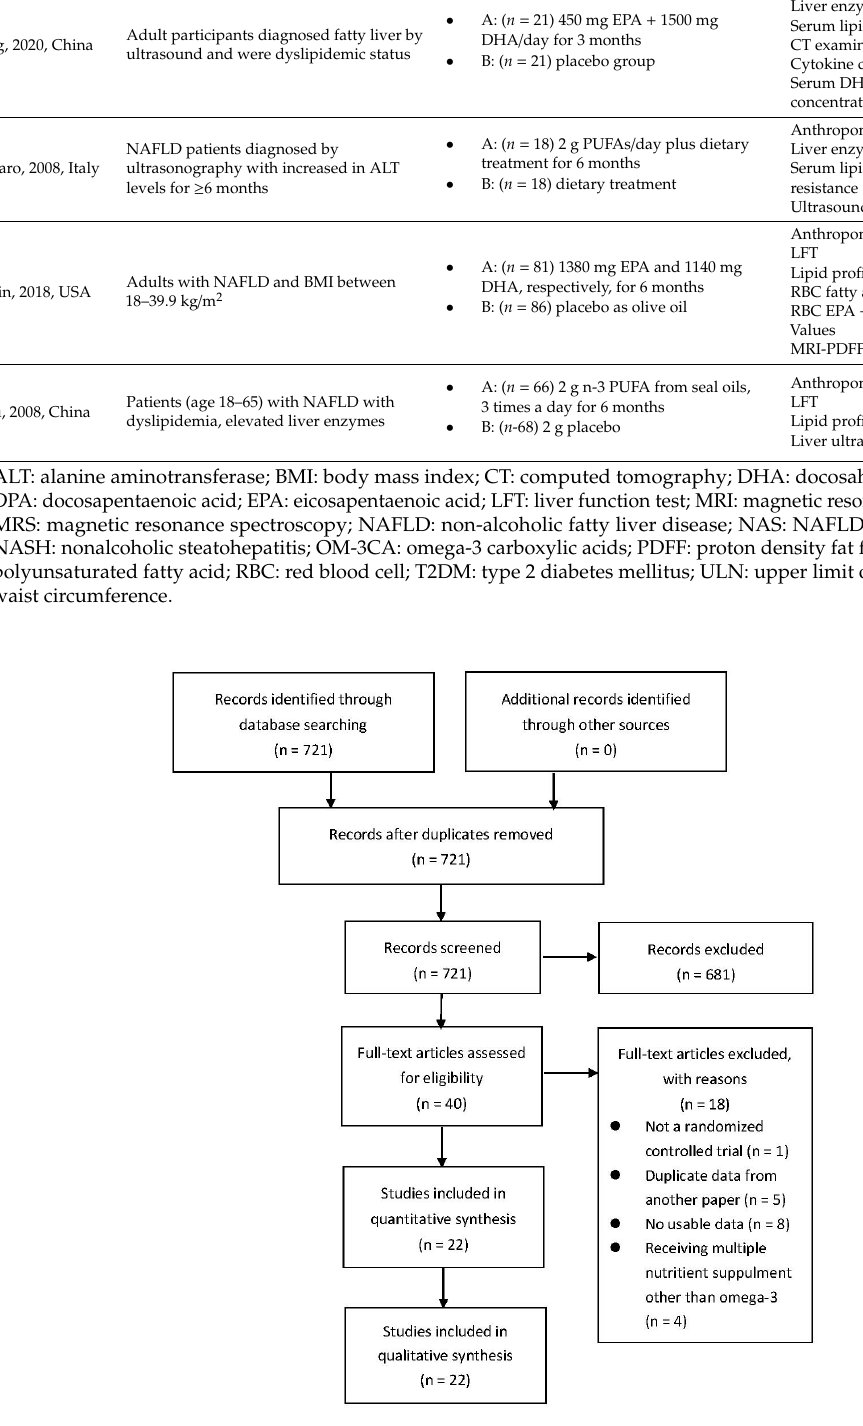
Figure 1. PRISMA Study Flow Chart. Table 2. Characteristics of included studies.